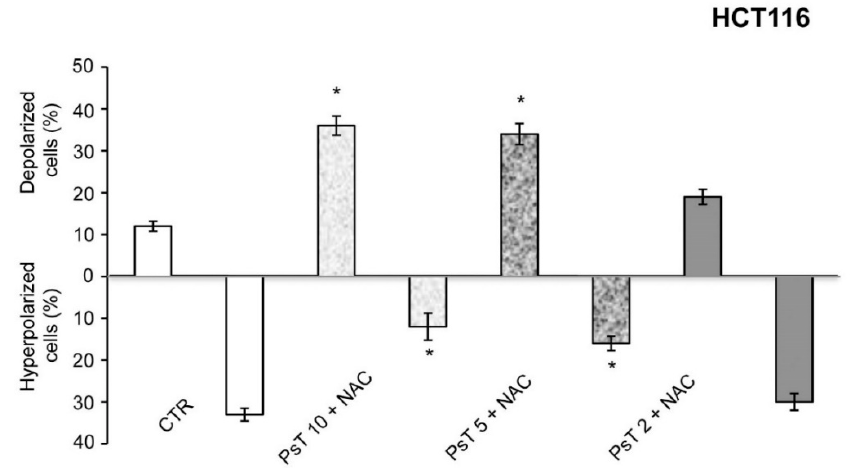
Figure 3. Effect of (PsT + NAC) ® treatment on mitochondria. Evaluation of mitochondrial membrane potential of HCT116 cells with tetramethylrhodamine methyl ester (TMRM) probe after PsT 10 mg/mL, PsT 5 mg/mL, PsT 2 mg/mL + NAC for 24 h. All combined treatments showed a dose-related